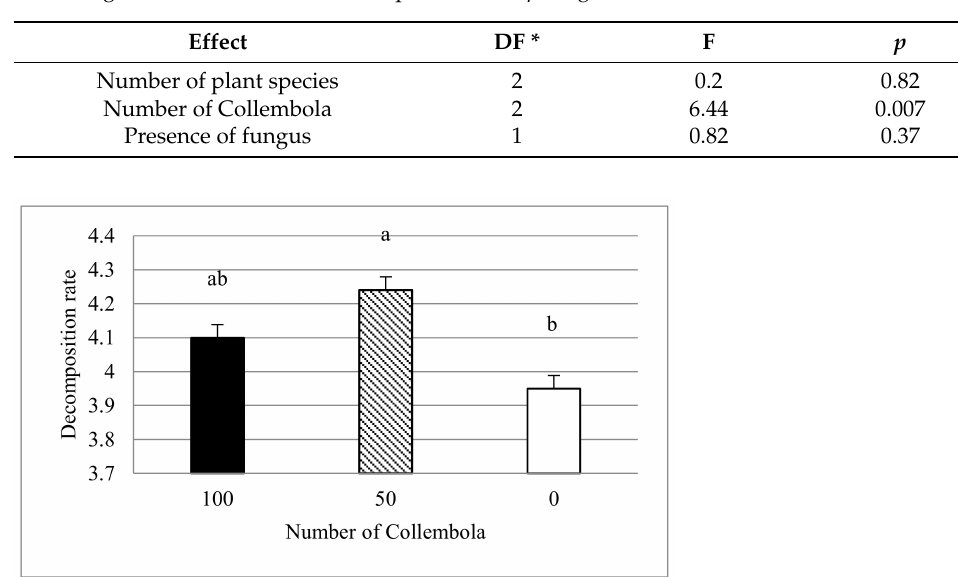
Figure 4. Several Fusarium colonies isolated from Collembola in pots incubated with (present) and without the fungus (absent). The different lowercase letters indicate significant differences between treatments, p ≤ 0.05. Table 4. Decomposition rate concerning the number of plant species (two variants), the number of Collembola individuals (three variants), and the present fungus (two variants) (mixed model).